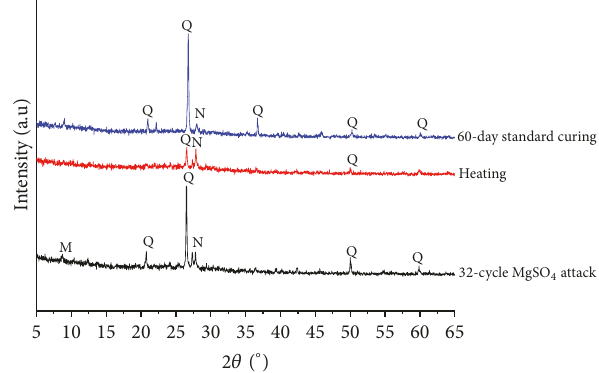
Figure8:XRDpatternsofFAGCinthe60-daystandardcuringcon- dition, heating condition, and 32-cycle MgSO 4 attack environment, respectively. Q: quartz; N: N-A-S-H (sodium aluminum silicate hydrate); M: M-A-S-H (magnesium aluminum silicate hydrate).